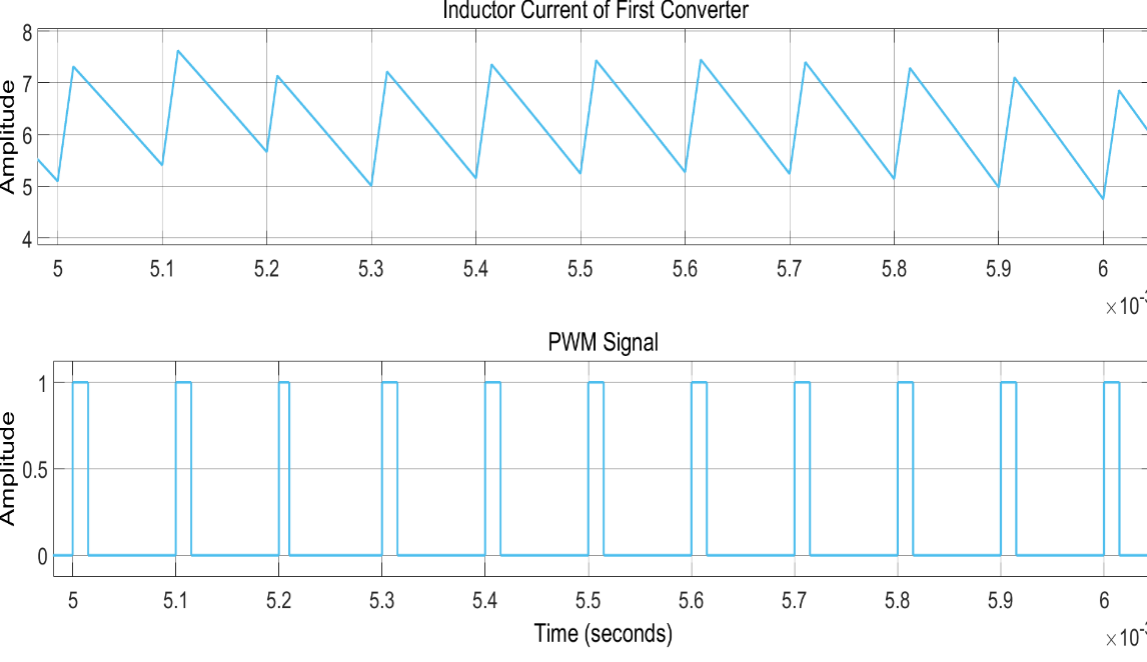
Figure 16. Inductor current w.r.t. gate pulses in converter CCM mode of operation.